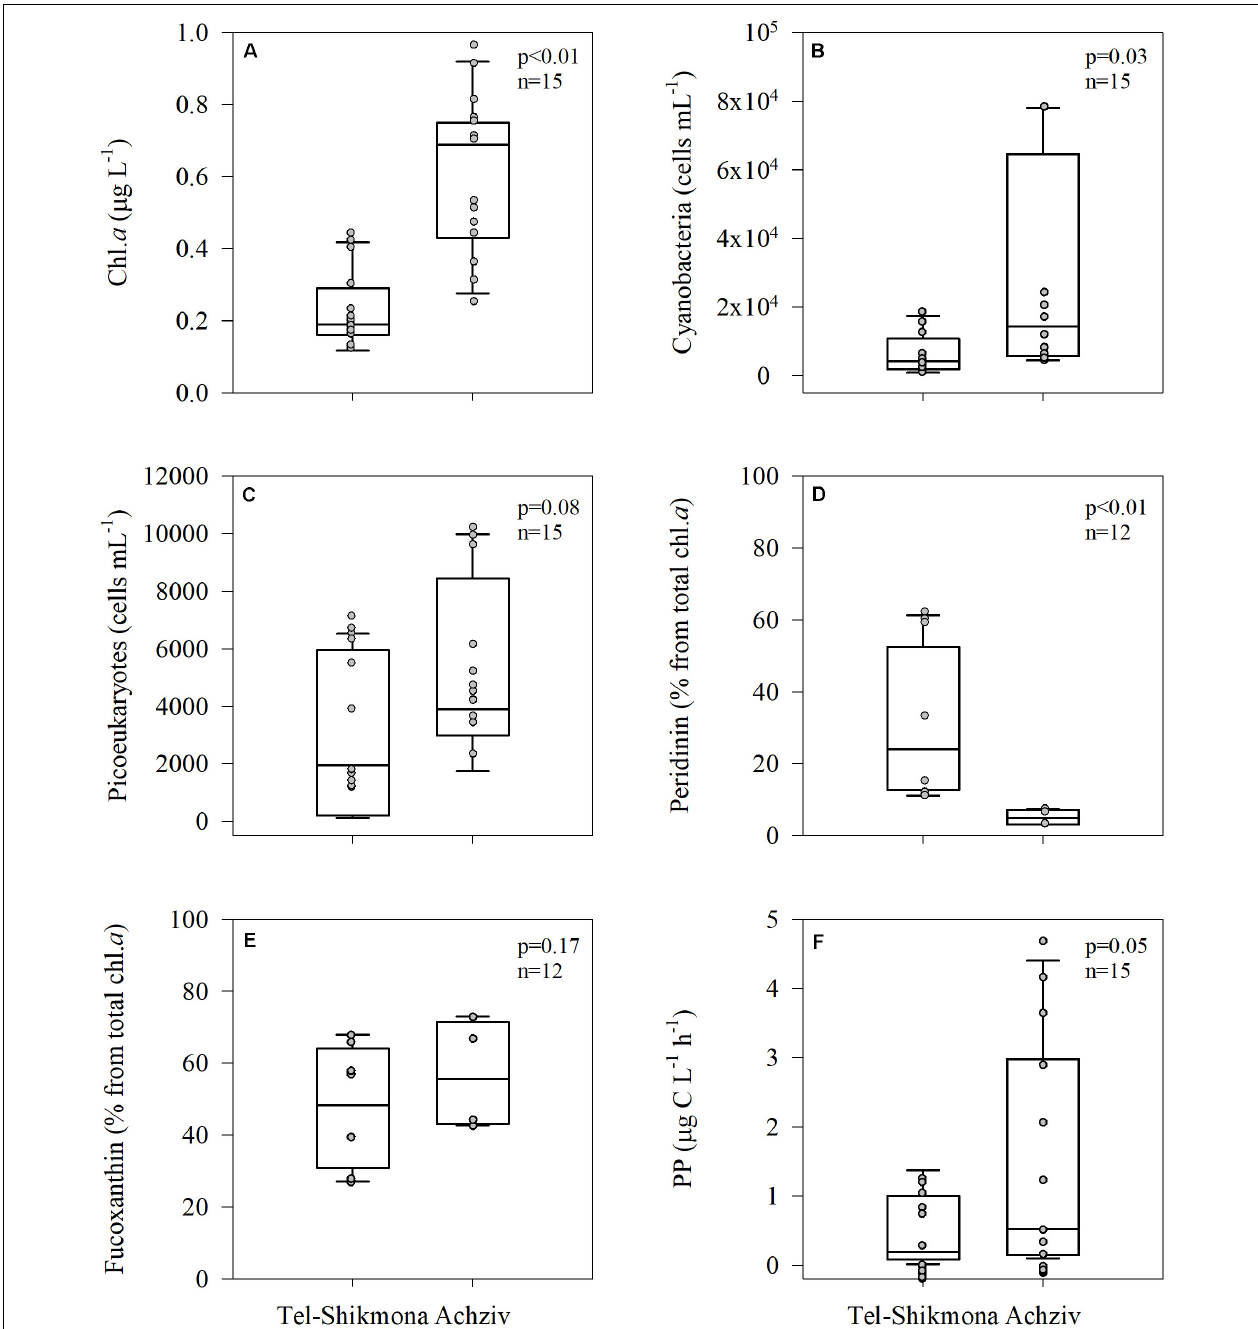
FIGURE 5 | Box-Whisker plots showing the interquartile range (25th to 75th percentile) and median value (horizontal line within the box) of chlorophyll a (A) , cyanobacterial abundance (B) , picoeukaryotes abundance (C) , peridinin (D) , fucoxanthin (E) , and primary production (PP) (F) in Tel-Shikmona and Achziv between 2013 and 2016. The measured values used to generate the box-plots are shown in gray.